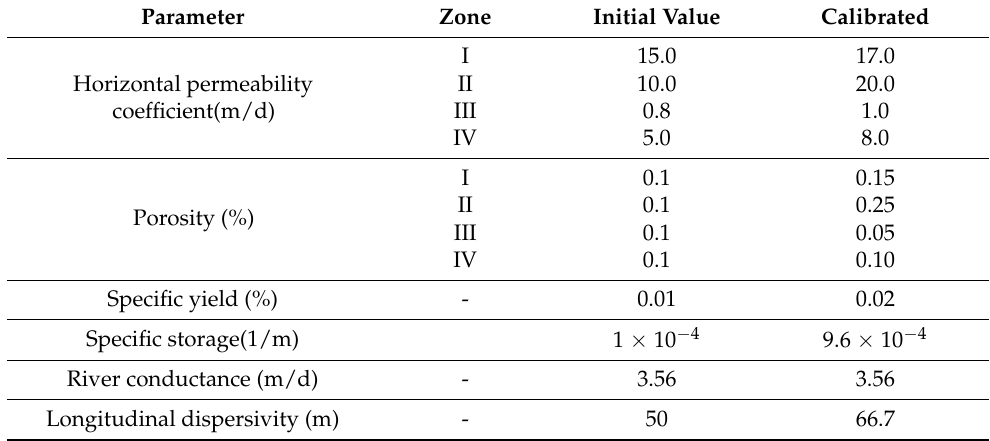
Table 2. Initial and calibrated values of hydrogeological parameters in different